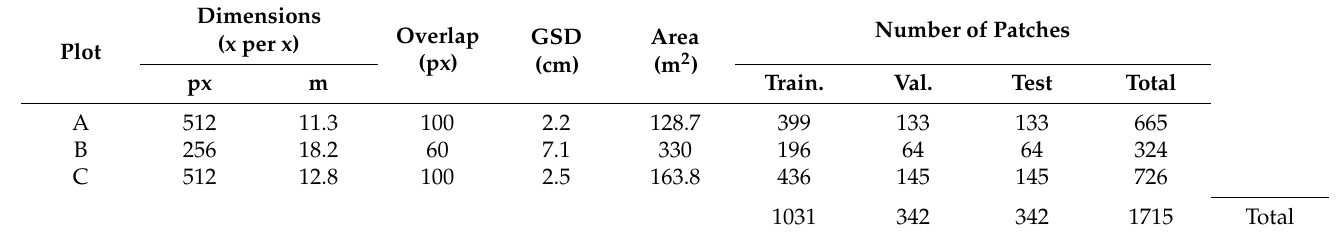
Table 2. Characteristics and number of patches used in both